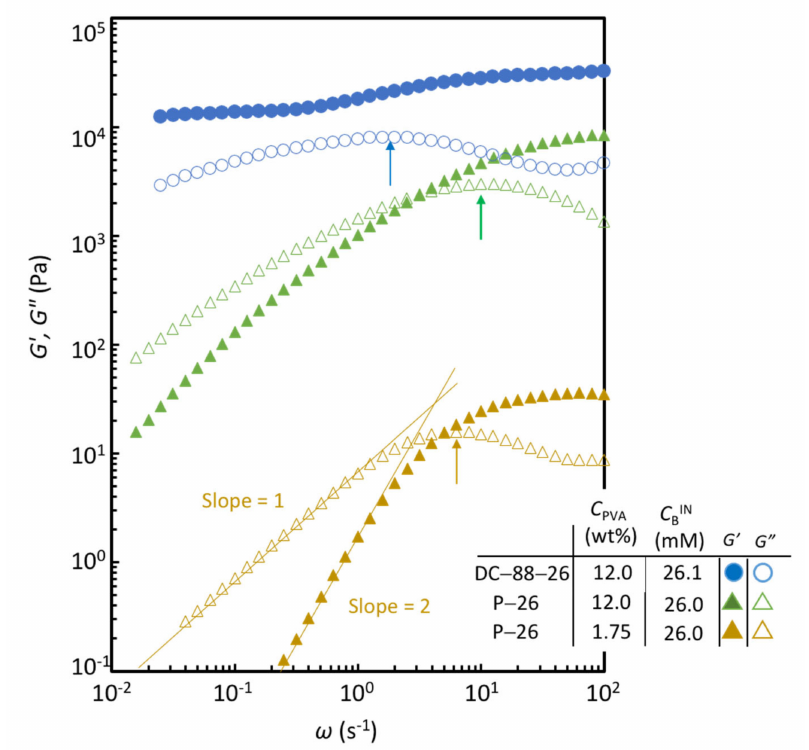
Figure 8. Comparison of the ω dependence of G (cid:48) and G ” for DC-88-26, P-26 with C PVA = 12.0 wt% and P-26 with C PVA = 1.75